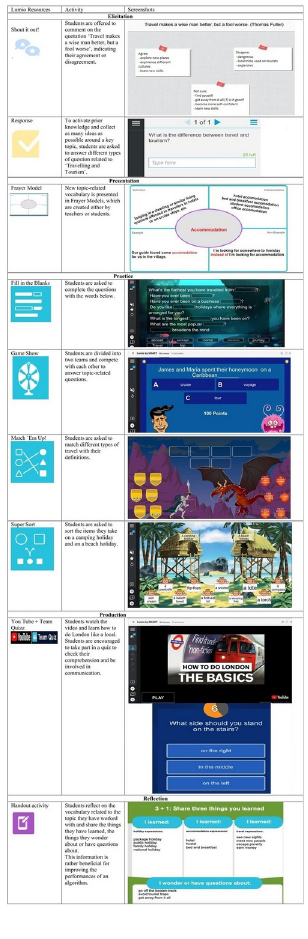
Figure 2 - The performance of a devised algorithm of teaching vocabulary via Lumio by